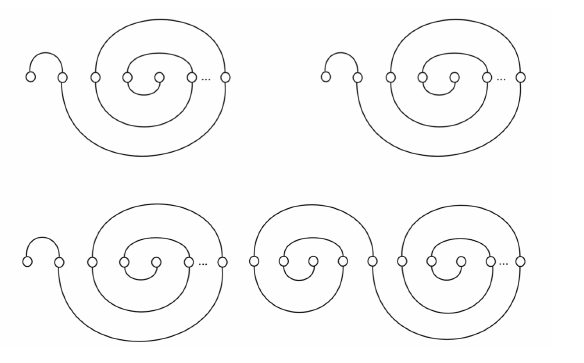
Figure 4. Meanders of the seaweed algebras i | j | k | j for n = i + 2 j + k (even case, above ) i − 1 | j + 1 | k − 1 | j + 1 | j | k | j and i for n = i + 2 j + k (odd case, below ). Note that the corresponding meanders are i − 1 | j + 1 | k − 1 | j + 1 not connected for even and odd numbers and that the components associated with the even case are